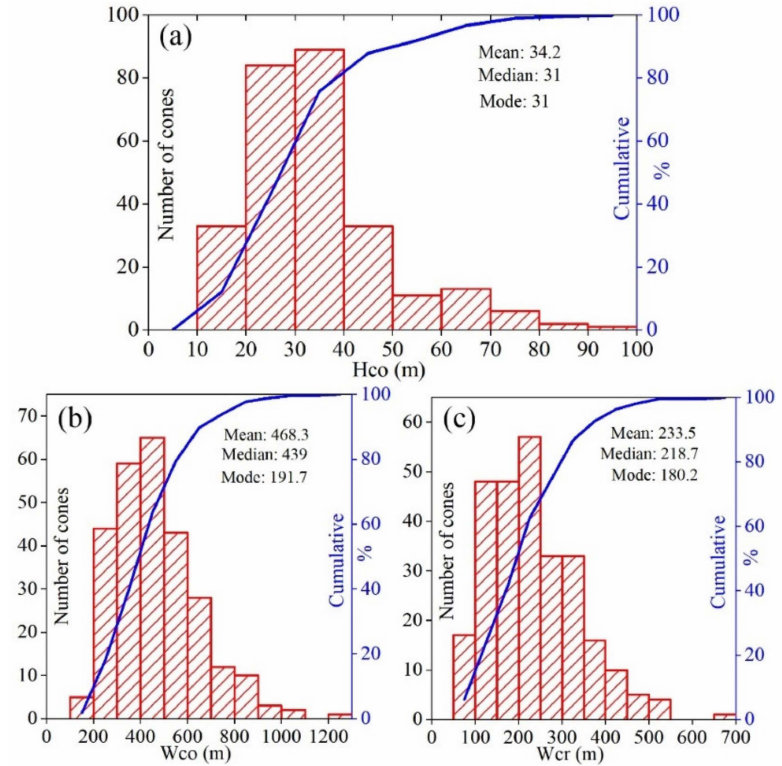
Figure 4. Frequency histograms and cumulative percentages of ( a ) cone height (Hco), ( b ) cone basal diameter (Wco), and ( c ) cone crater width